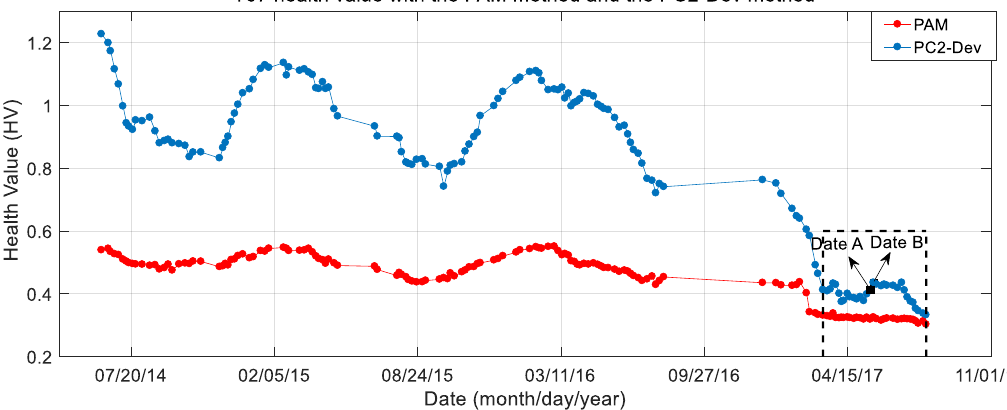
Figure 9. Health assessment result of T07 wind turbine obtained using two methods.